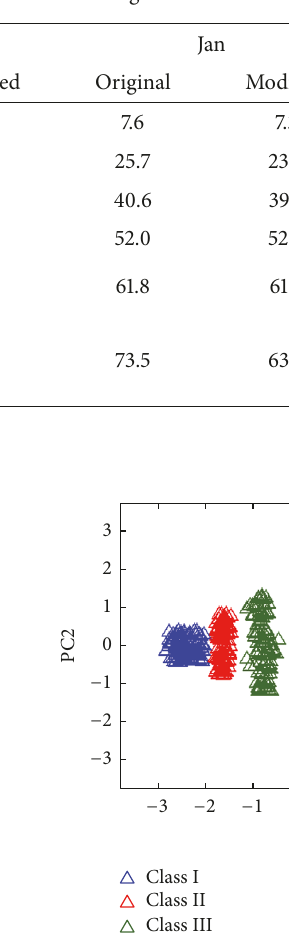
Table 7: The cumulative weighted subindices for the original and modified DOE-WQI.